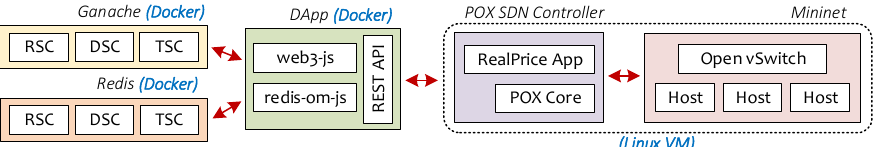
Figure 2. The testbed environment used for our evaluation. Mininet, POX SDN controller, and our SDN application reside in a single Linux virtual machine (VM). Meanwhile, the decentralized application (dapp) exists in a separate Docker container along with Ganache (for with-blockchain case) and Redis (for without-blockchain